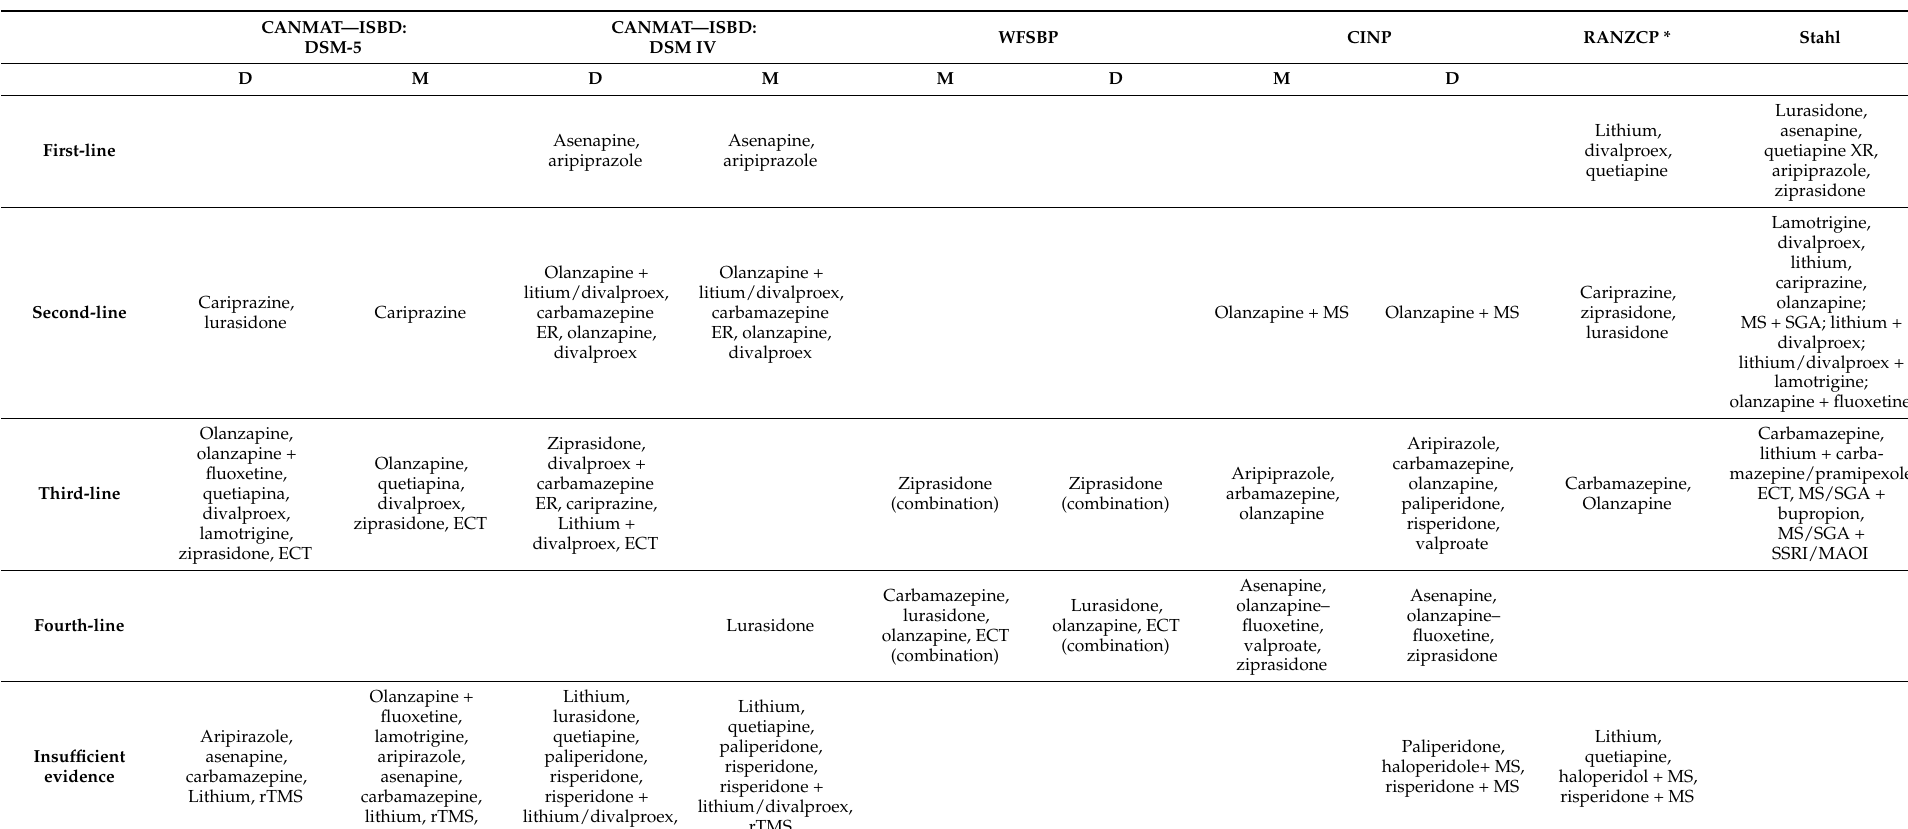
Table 1. Pharmacological treatment for the acute phase of mixed depression